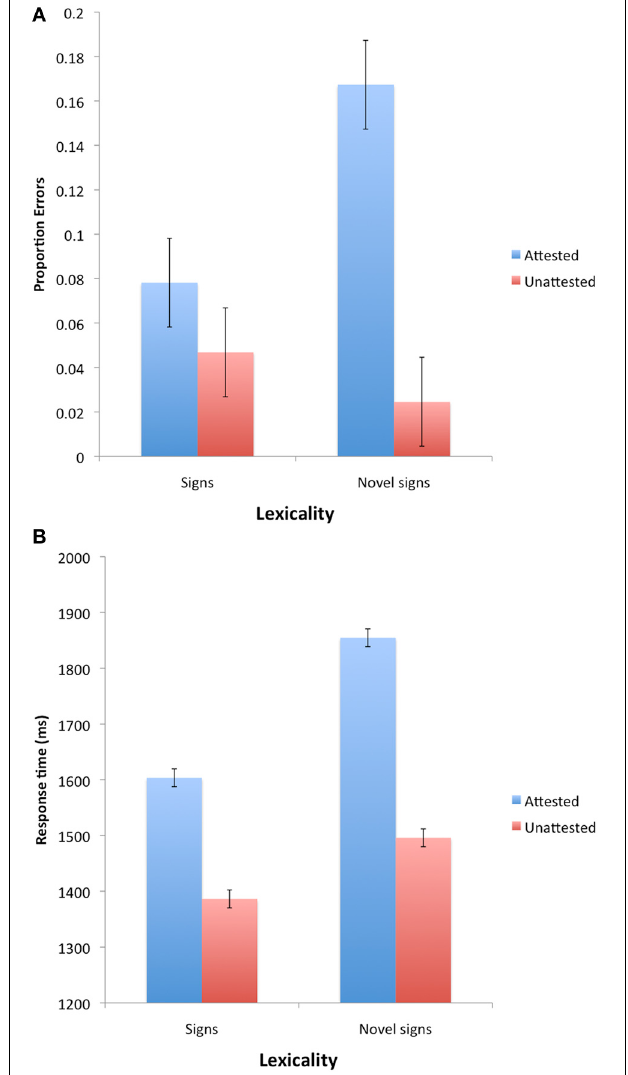
FIGURE 7 | The effect of handshape attestation on lexical decision across experiments. Note: Error bars are 95% confidence intervals for the difference between the